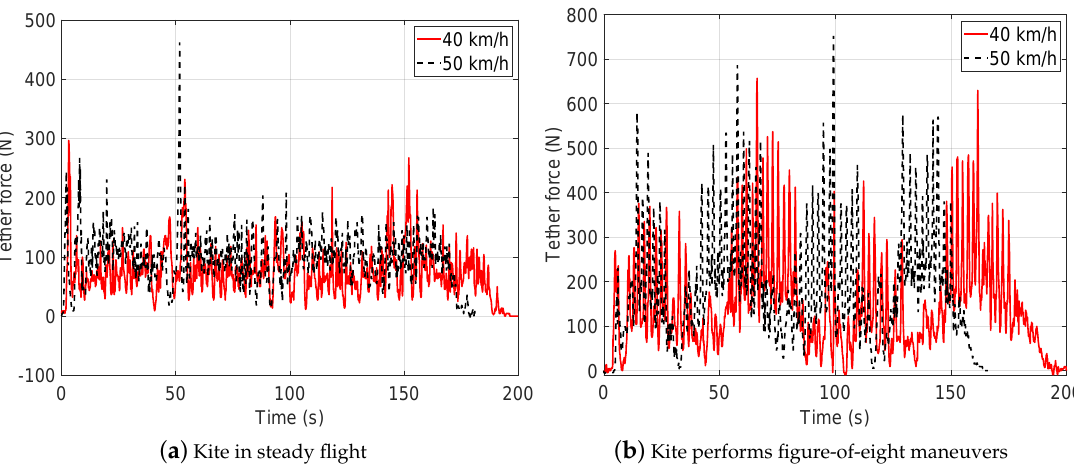
( b ) Kite performs figure-of-eight maneuvers Figure 10. Effect of towing speed for tests 1 & 3 and 2 &